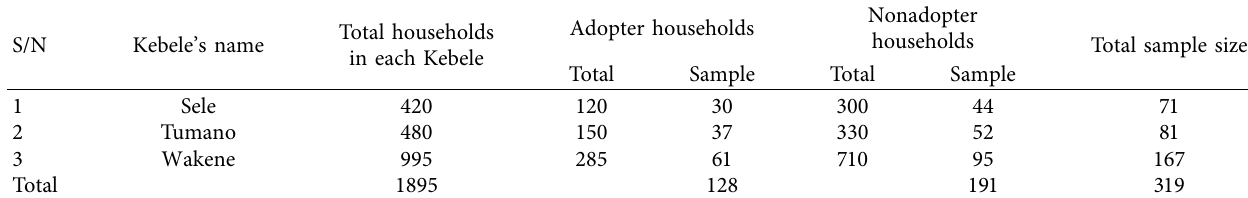
Table 1: Sample size and distribution by sample